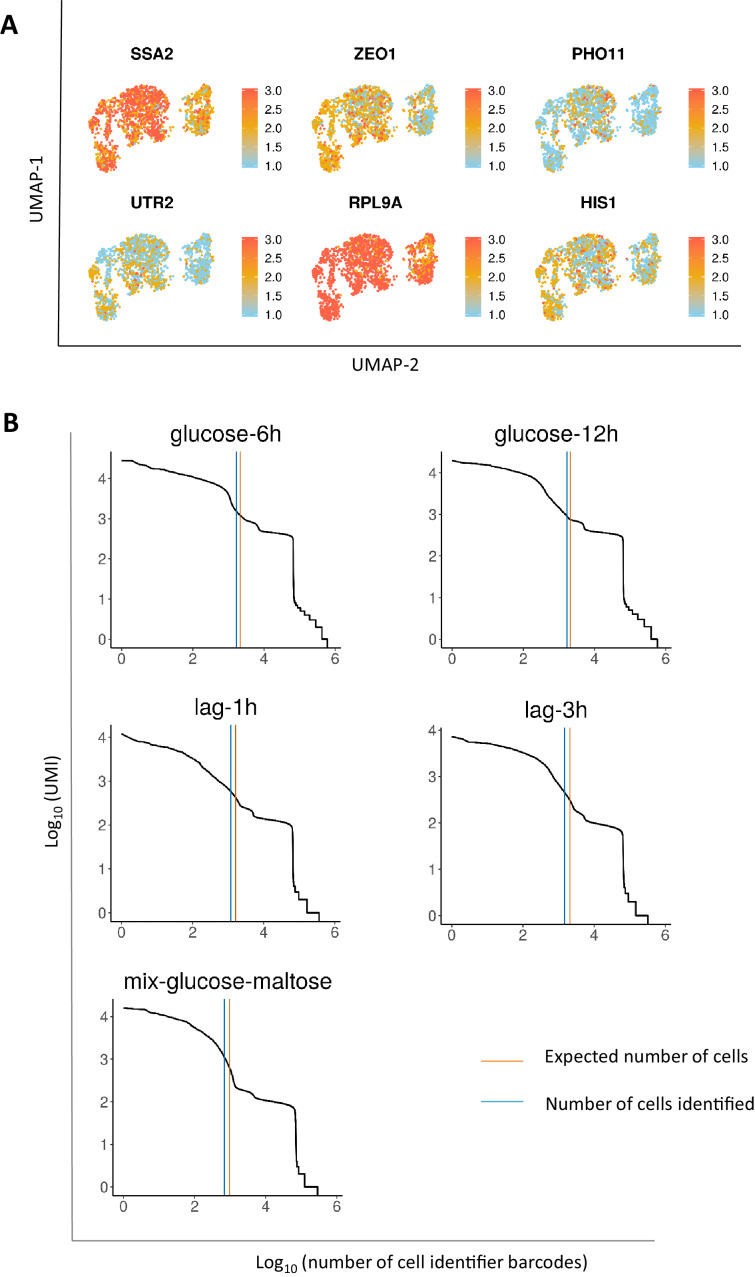
Glucose-growth-specific markers and comparison of expected vs detected number of cells.(A) UMAP projection of glucose-specific growth markers in the aggregated glucose-12h and mix-glucose-maltose samples. (B) UMI count as a function of per-droplet barcodes. The blue line demonstrates the number of cells identified using the Cell Ranger software. The orange line demonstrates the number of expected cells based on the number of cells loaded. Details on the number of cells loaded and the expected number of cells is provided in the methods section.